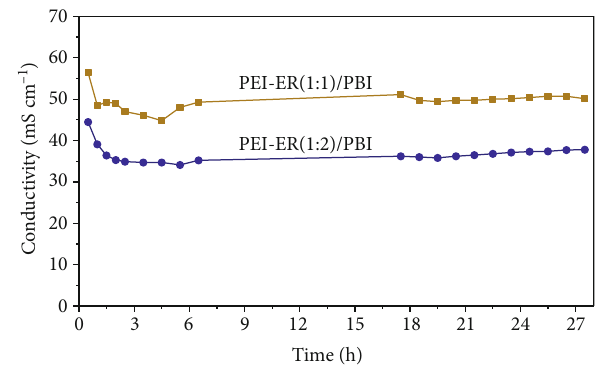
Figure 6: Variation of proton conductivity of PA-doped